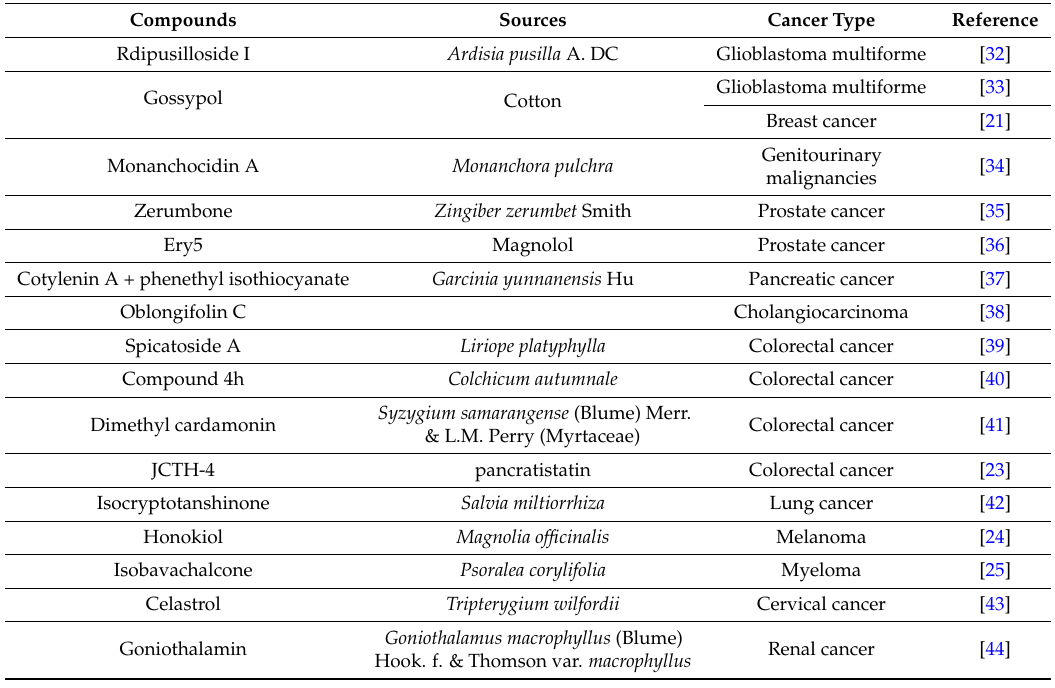
Table 1. Natural autophagic inducers from compound names and herb sources evaluated for various types of